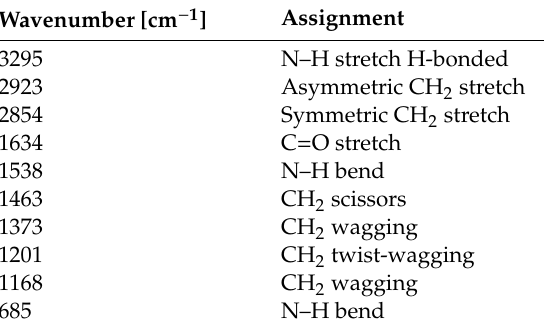
Table 3. FTIR frequencies and vibrational assignments for the copolyamide.